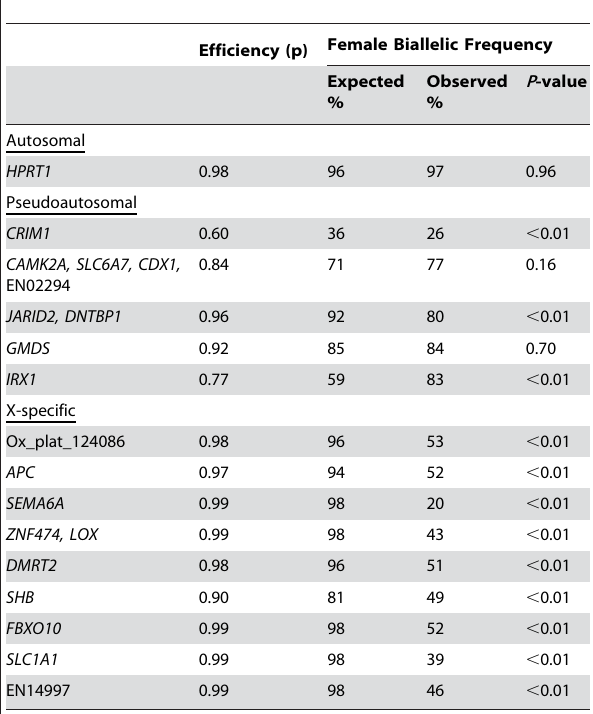
Table 5. Expected vs observed frequency of nuclei with biallelic expression in females.